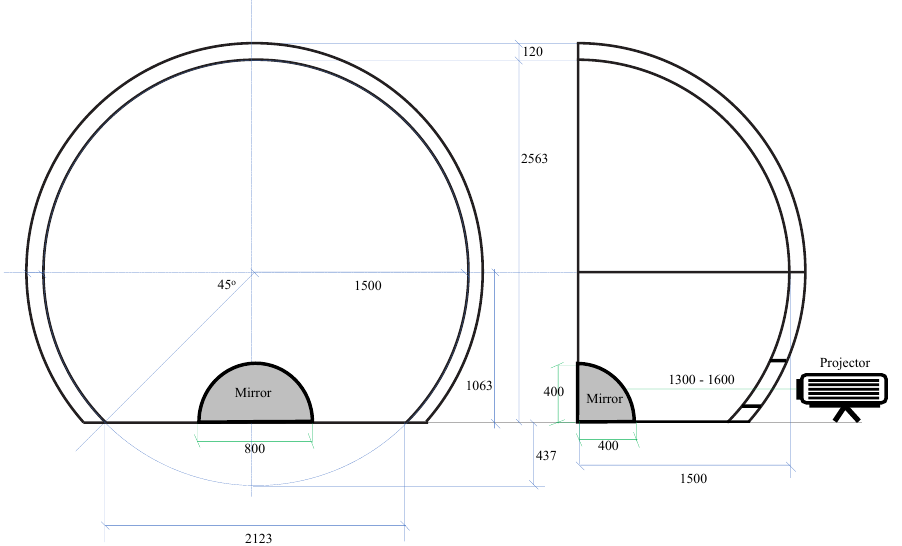
Figure 3. iDome front and side view dimensions in